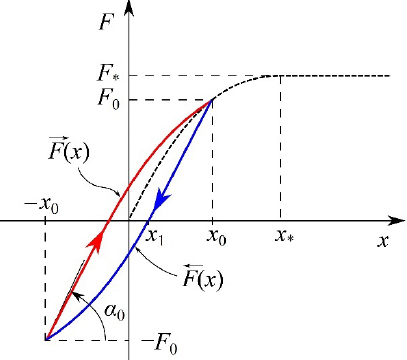
Fig. 2 Schematic diagram for a hysteresis loop of the Masing model in partial slip. (A hysteresis curve, which enters the gross slip stage, has been shown in Fig. 3.)